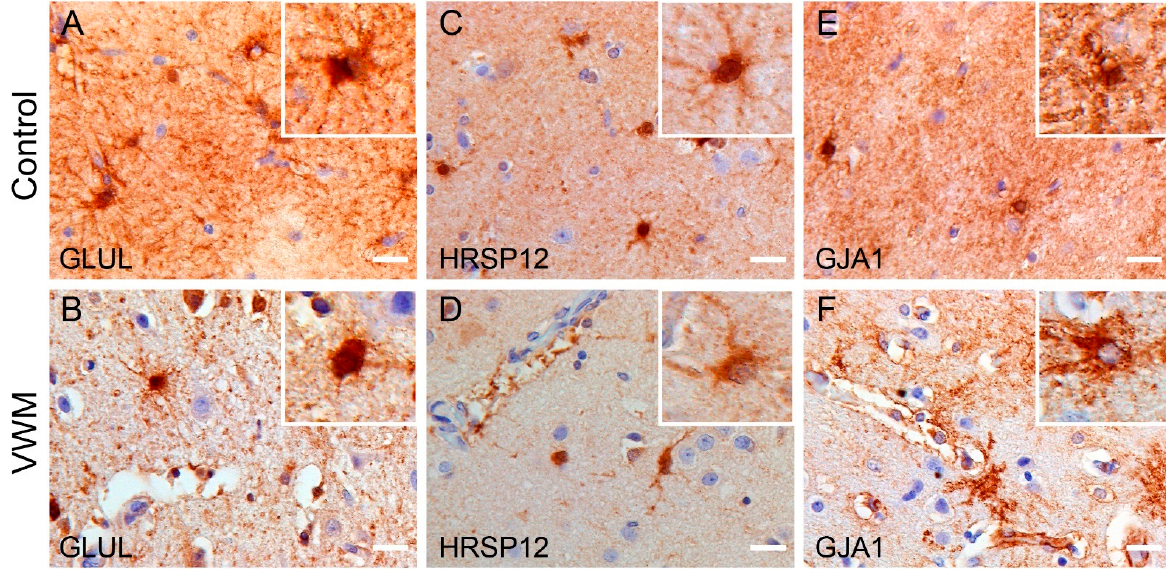
Figure 5. Expression pattern of GLUL, HRSP12 and GJA1 in control and VWM cortices. ( A – F ) Expression pattern of GLUL, HRSP12 and GJA1 in control and VWM cortices. Immunohistochemistry against GLUL, HRSP12 and GJA1 in control cortex (upper panel) and VWM ( A – F ) Immunohistochemistry against GLUL, HRSP12 and GJA1 in control cortex ( upper panel ) cortex (bottom panel). Insets are higher magnification images, showing immunoreactive cells with and VWM cortex ( bottom panel ). Insets are higher magnification images, showing immunoreactive astrocyte-like morphology. Blue stain indicates nuclei. Scale bars: 20 µm. Depicted images are stains of cortical tissue of control 4 and VWM 3. cells with astrocyte-like morphology. Blue stain indicates nuclei. Scale bars: 20 µ m. Depicted images are stains of cortical tissue of control 4 and VWM